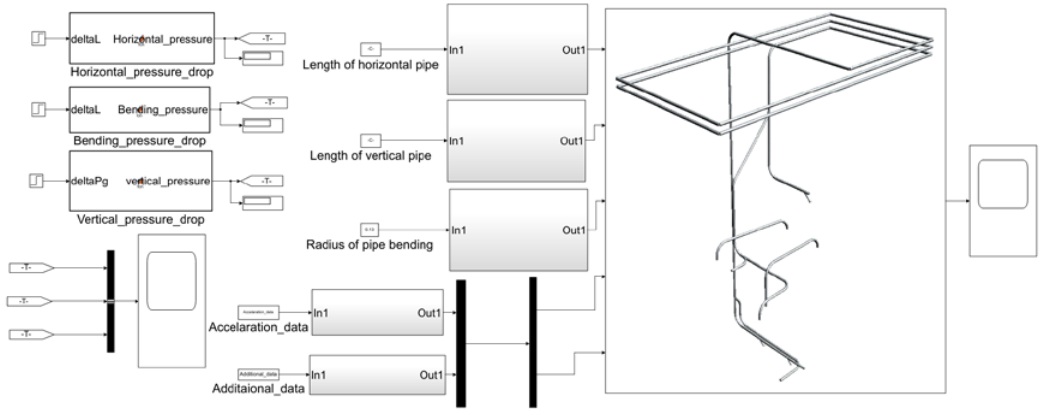
Figure 5. Physical modeling of BTS for pressure drop.